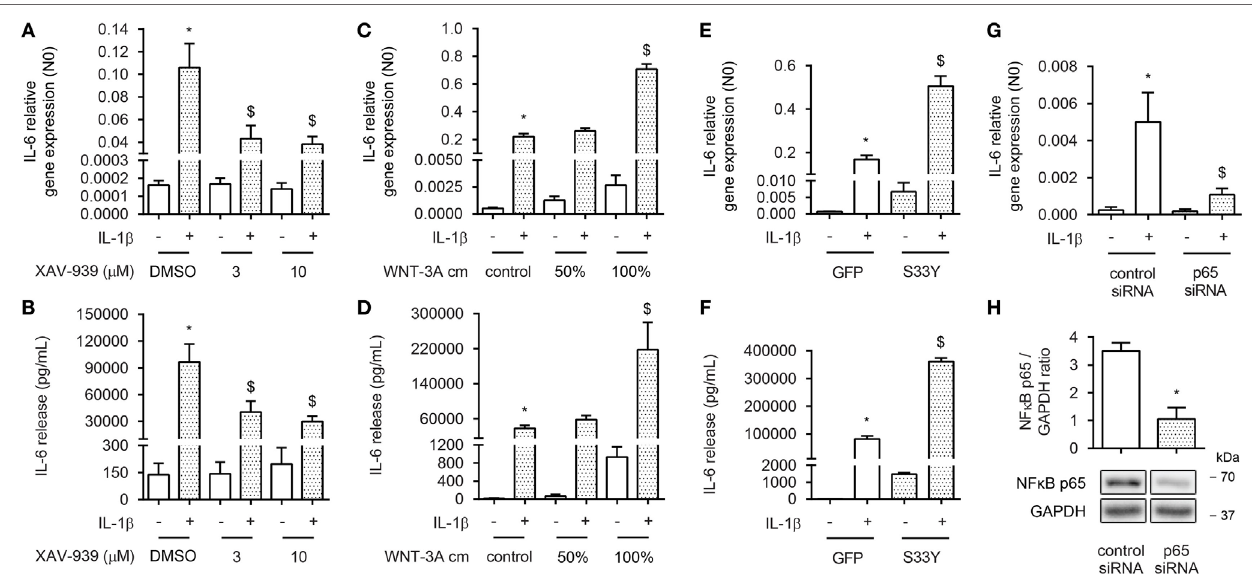
FigUre 1 | β -Catenin is required for interleukin-1 β (IL-1 β )-induced expression of IL-6. (a) IL-6 mRNA and (B) secreted protein from airway smooth muscle cells exposed to IL-1 β (1 ng/mL) for 16 h (a) or 24 h (B) with or without XAV-939 (3 and 10 µM). RNA was isolated and subjected to RT-qPCR (a) , whereas cell supernatants were subjected to enzyme-linked immunosorbent assay (ELISA) (B) . Data represent four and six independent experiments for (a,B) , respectively. (c) IL-6 mRNA and (D) secreted protein from airway smooth muscle exposed to IL-1 β (1 ng/mL) for 16 h (c) or 24 h (D) with or without WNT-3A conditioned medium. Data represent four independent experiments. (e) IL-6 mRNA and (F) secreted protein from airway smooth muscle cells exposed to IL-1 β (1 ng/mL) for 16 h (e) or 24 h (F) while transiently transfected with a green fluorescent protein (GFP) or S33Y-construct. Data represent four independent experiments. (g) IL-6 mRNA of airway smooth muscle exposed to IL-1 β (1 ng/mL) for 16 h while transiently transfected with control or p65 small-interfering RNA (siRNA). Data represent four independent experiments. (h) NF- κ B p65 immunoblot, normalized against GAPDH. Cells were transfected with 30 pmol control or p65 siRNA for 24 h. Data represent four independent experiments. * vs. control, $ vs. IL-1 β